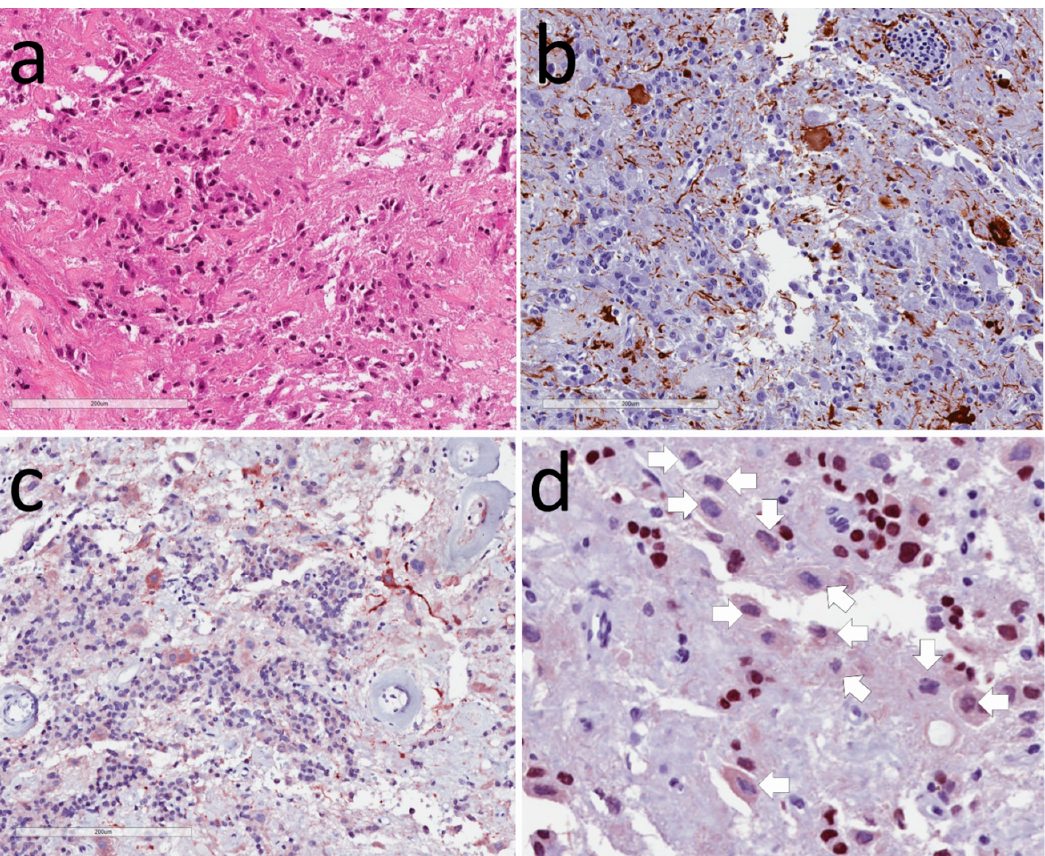
Figure 1. Hypothalamic gangliocytoma associated with a somatotroph tumor. ( a )Hematoxylin and eosin (H&E) stain identifies two cell populations; ( b ) Neurofilament highlights the neurons; ( c ) Growth hormone-releasing hormone (GHRH) is localized to the neurons; ( d ) PIT1 stains the nuclei of somatotroph, but not neurons (arrows).